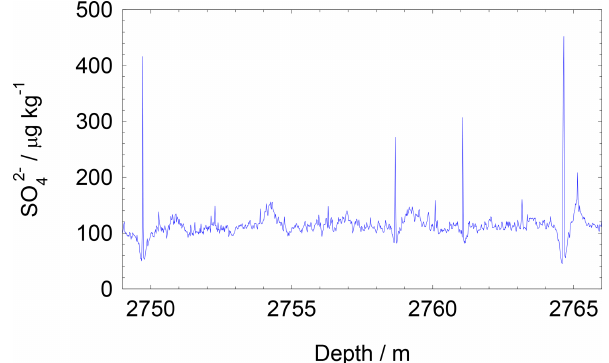
Figure 3. An example of four artefact peaks in ice aged just over